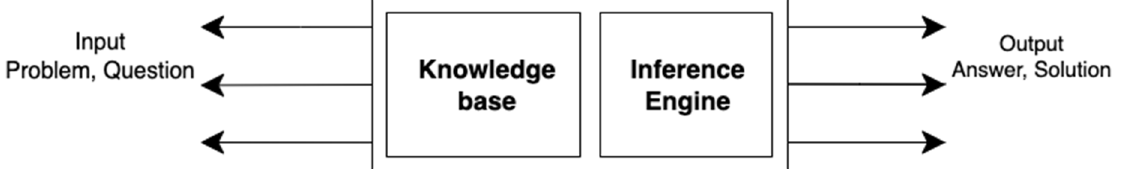
Figure 5. Main parts of AI.